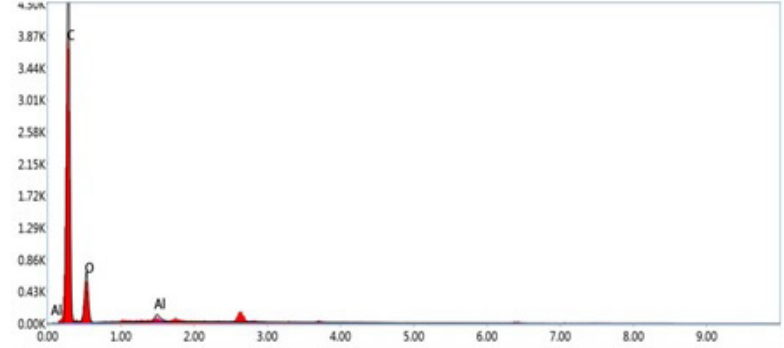
Figure 14. EDX of coated M2N1 composites on steel